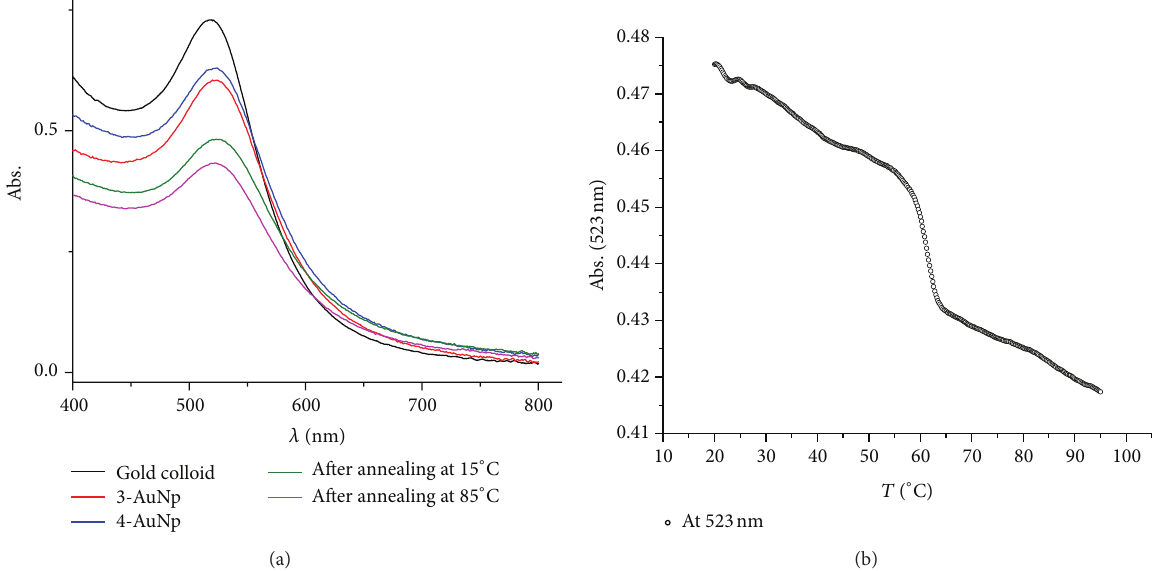
Figure 2: (a) UV-vis absorbance spectra of gold colloid (black), 3 -AuNp, 4 -AuNp conjugates (red and blue resp.) and 3 -AuNp+ 4 -AuNp after annealing measured at 15 ∘ C (green line) and at 85 ∘ C (pink line). (b) Melting curve of 3 -AuNp+ 4 -AuNp measured at 523 nm.